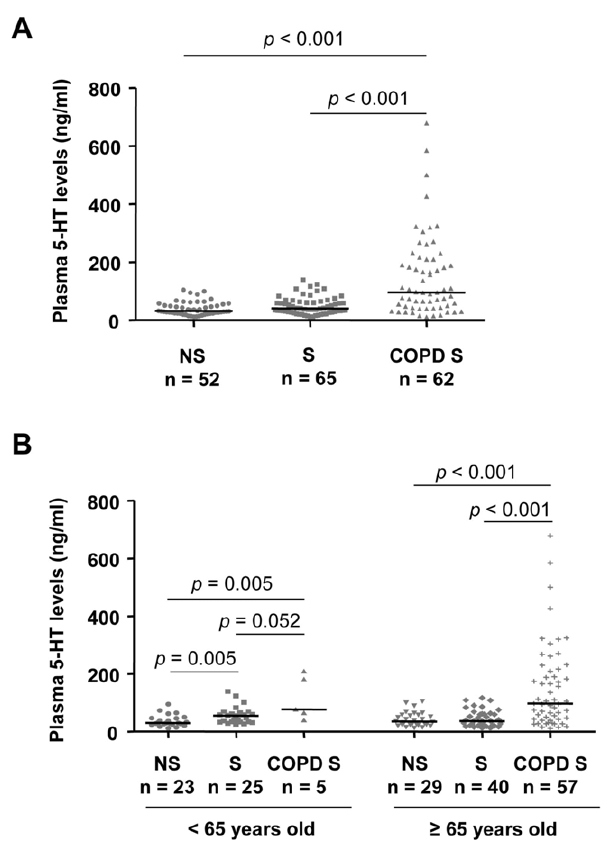
Figure 1. Plasma 5-HT levels across COPD patients and control subjects. (A) Plasma 5-HT levels of healthy non-smokers (NS), healthy ever-smokers (S) and COPD ever-smokers (COPD S). (B) Plasma 5-HT levels of healthy non-smokers (NS), healthy ever-smokers (S) and COPD ever-smokers (COPD S) in those , 65 years old and $ 65 years old. Solid horizontal line represents the median value. P values were obtained from the Mann-Whitney U test.